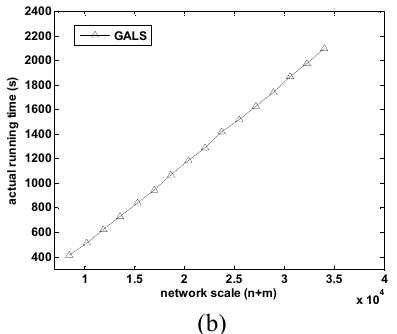
Fig. 6. (Color online) Test the performance of GALS on Newman benchmark. (a) Compare GALS with GN, FN, FEC, FUA, TGA and GACD in terms of NMI accuracy; (b) The actual running time of GALS is as a function of the network